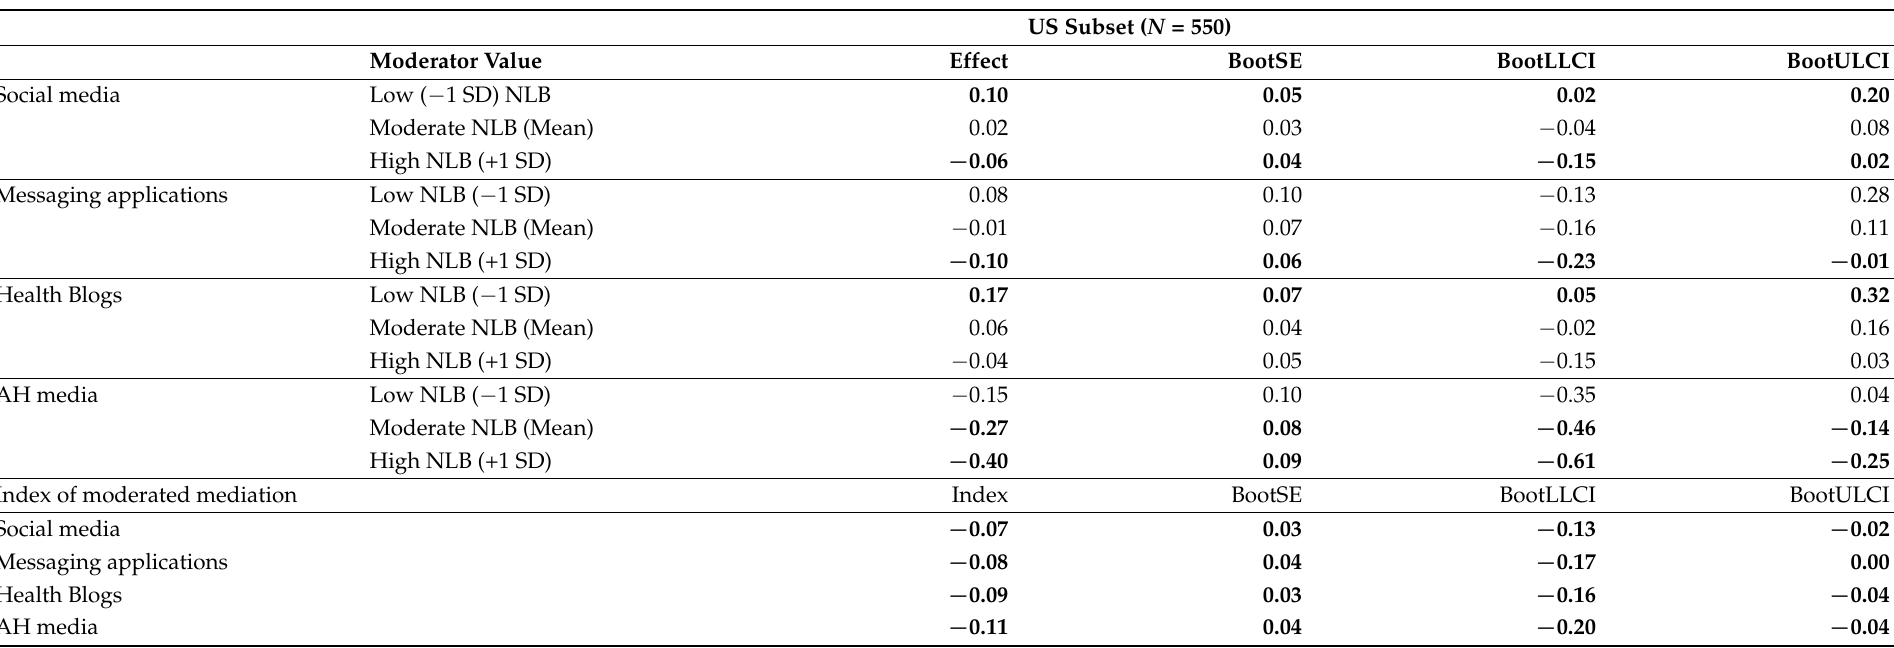
Table A3. The moderated mediation effect of media reliance for COVID-19 news on vaccination behavior (US